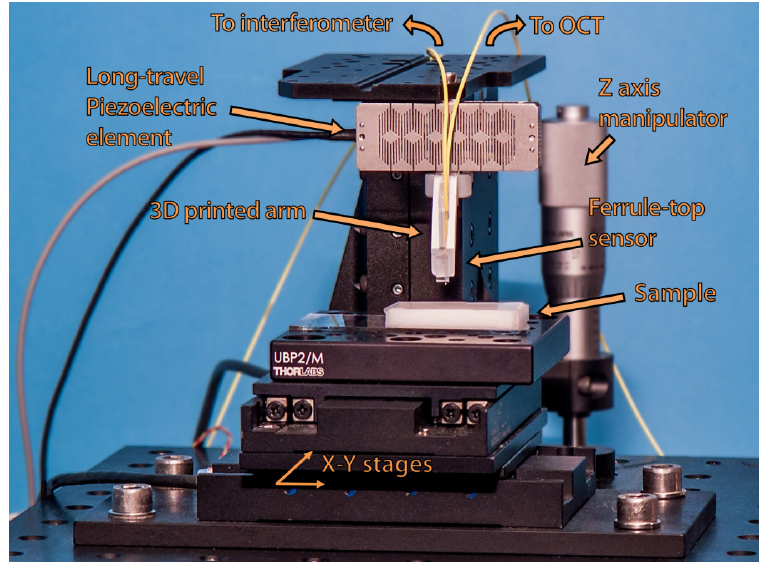
Fig. 3. Overview of the setup: OCT imaging is obtained by moving the sample with the X – Y stages while the sensor hovers at approximately 800 (cid:1) m above the sample. Indentation measurements make use of the interferometric readout and are driven by the piezoelectric element.